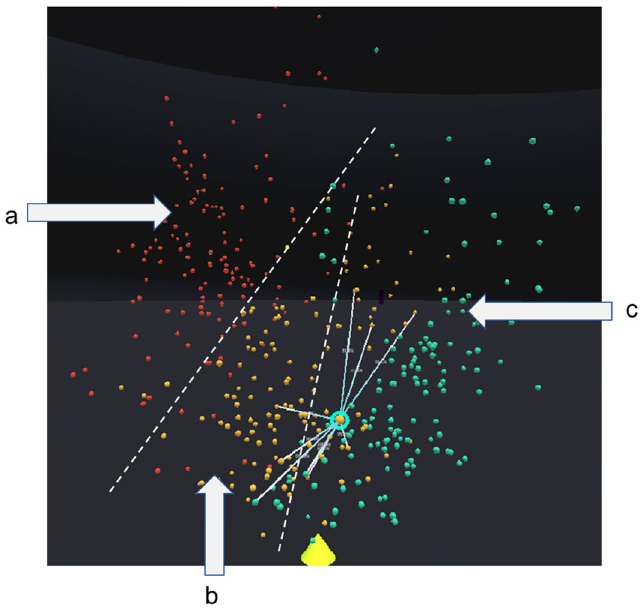
Figure 2. A close-up of the 3D similarity space of the patient cohort for the OHSC threerisk dataset. Colours are used to indicate the risk level. The cohort can roughly be divided into three regions, a, b and